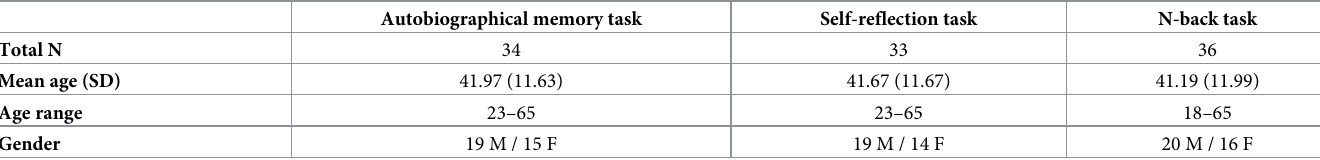
Table 1. Demographic characteristics of the final samples for each